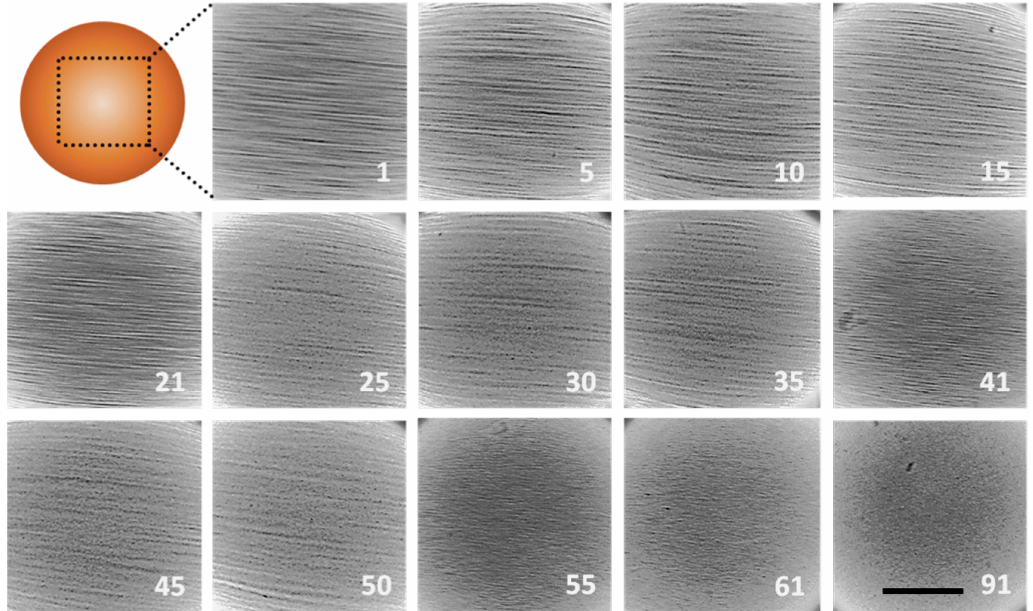
Figure 5. Optical micrographs of the central part of some individual microstructures in a 20 × 20 printed array. The positions of the structures within the array are given by the numbers. The scale bar is 50 μm